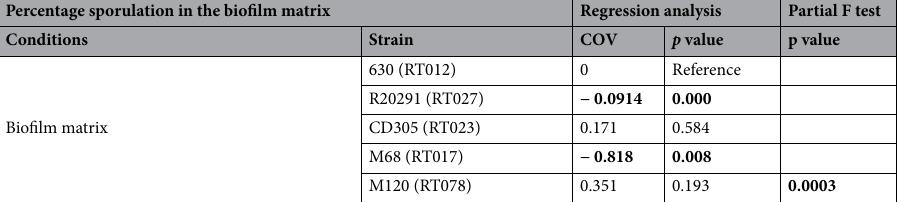
Table 2. Statistical analysis. Showing the Students T test p values, the Partial F test p value for the groups analysed by linear regression and linear regression Coefficient of Variance and p